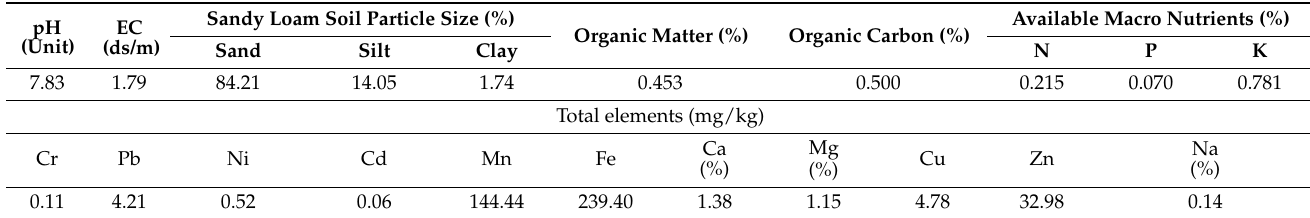
Available Macro Nutrients (%)